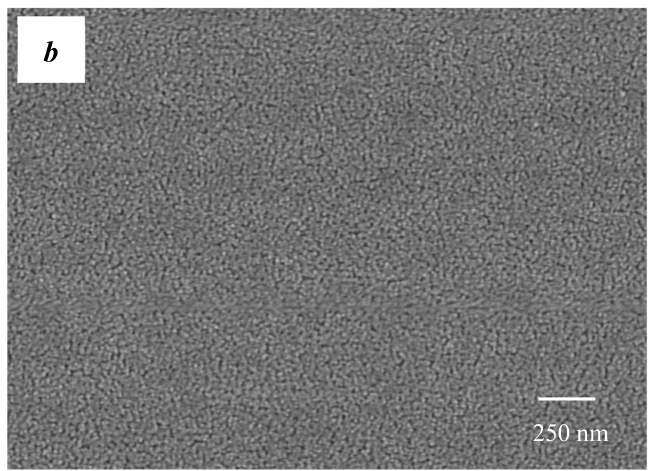
Figure 9. Field emission SEM (FE-SEM) images for ( a ) SnO 2 and ( b ) B/Ag/F tridoped SnO 2 -ZnO heated at 550 ◦ C in the atmosphere for 1